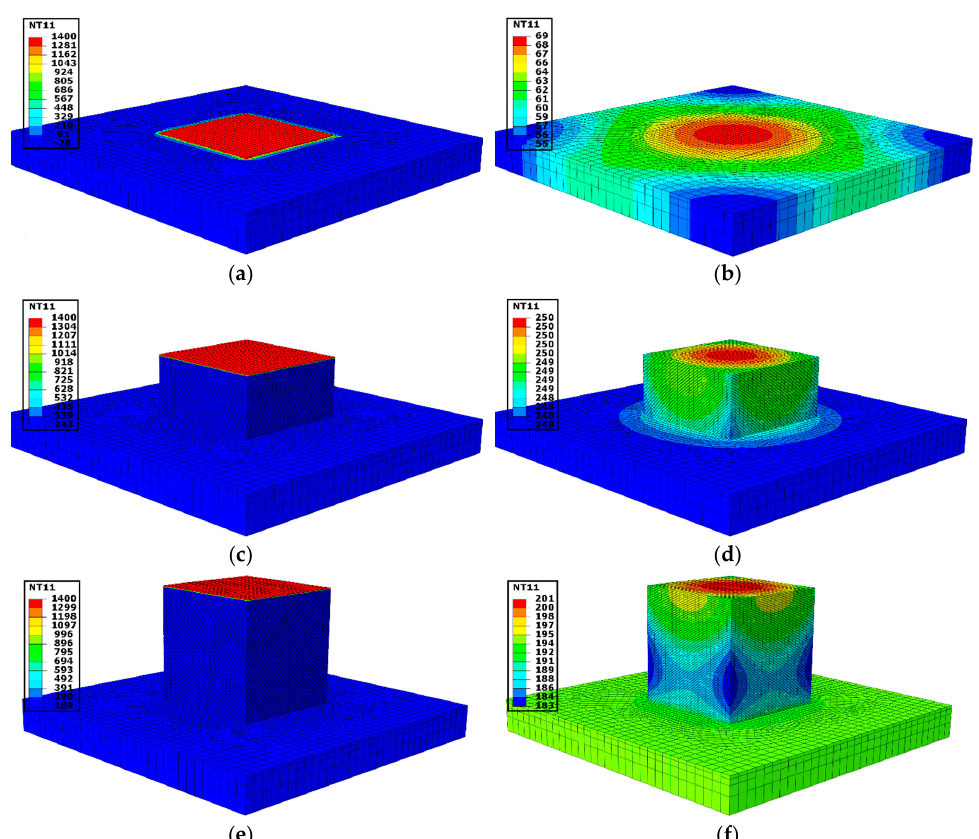
Figure 15. Temperature (°C) evolution at different layers during thermal simulation of 3D cubic structure. The nodal temperature where the first layer ( a ), the 70th layer ( c ) and the 140th layer ( e ) of element reaches 1400 °C; and temperature gradient at the end of the step time for the first layer ( b ), the 70th layer ( d ) and the 140th layer ( f ).